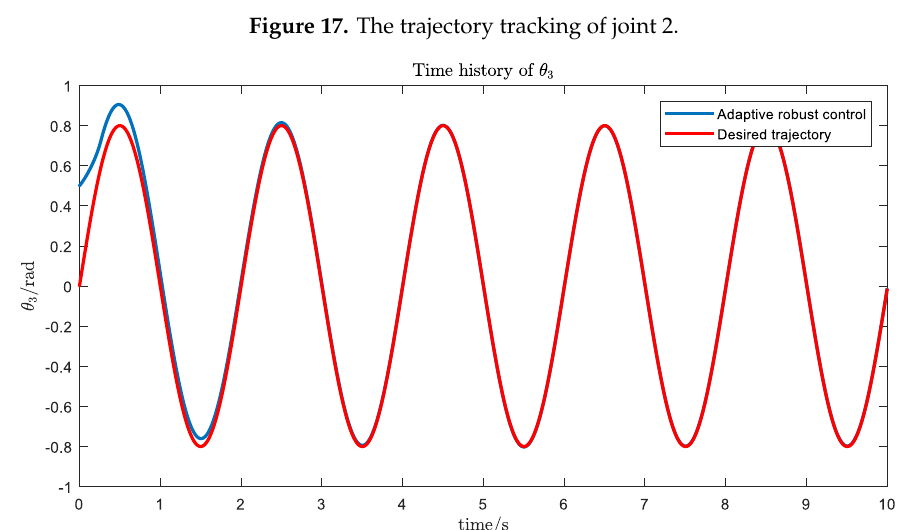
Figure 18. The trajectory tracking of joint 3.